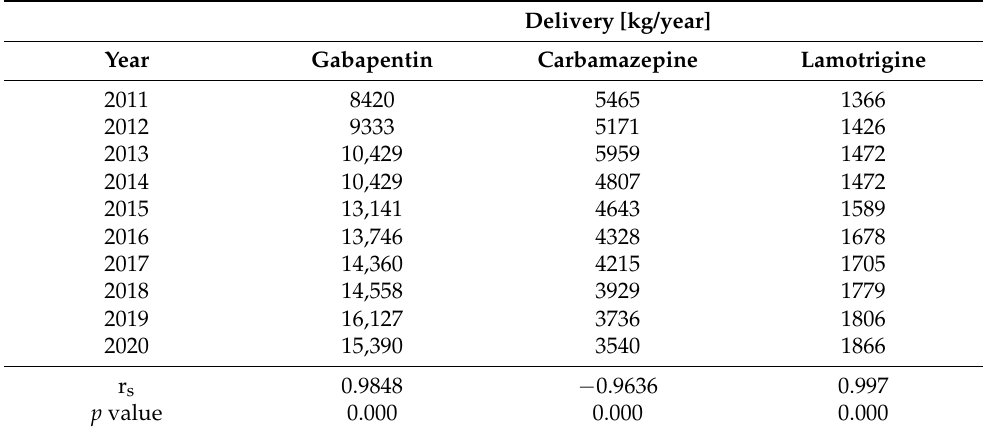
Table 1. Trend of usage (based on the delivery of drugs to pharmacies and medical facilities) of selected anticonvulsive pharmaceuticals in the Czech Republic during years 2011–2020. Data were obtained from the State Institute for Drug Control, Czech Republic (www.sukl.cz). Relationship between years and usage was analyzed using the Spearman’s rank-order correlation (r s